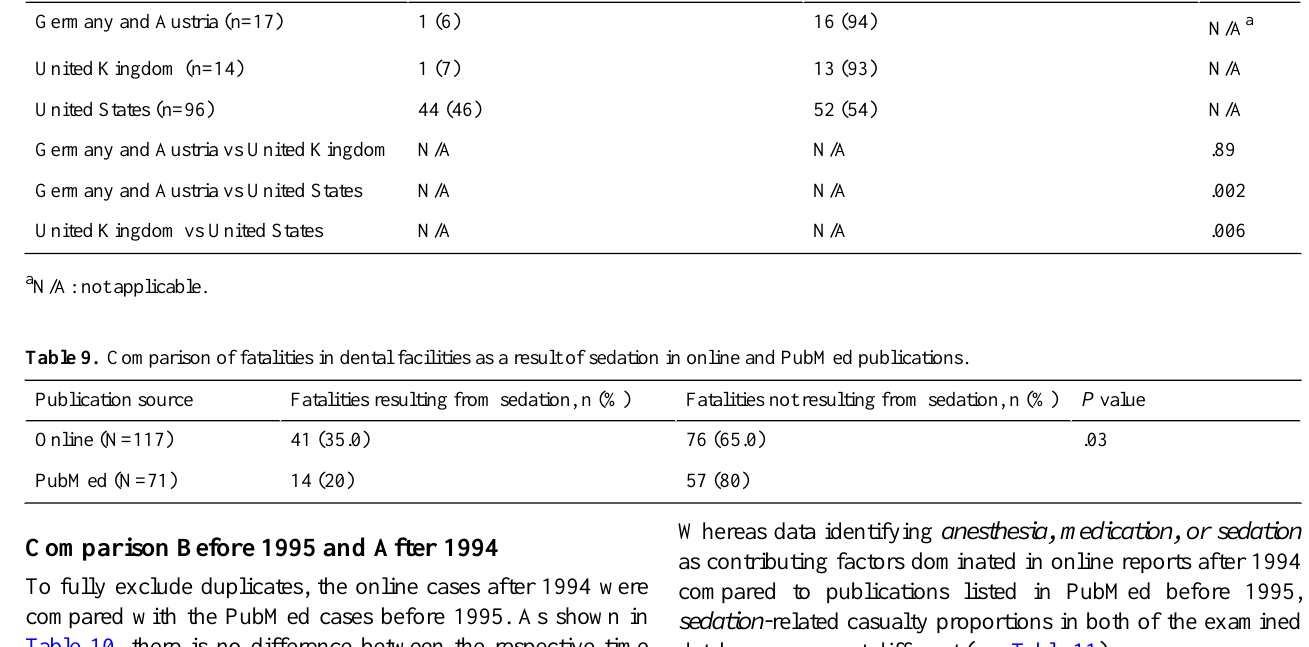
P valueFatalities not resulting from sedation, n (%)Fatalities resulting from sedation, n (%)Country